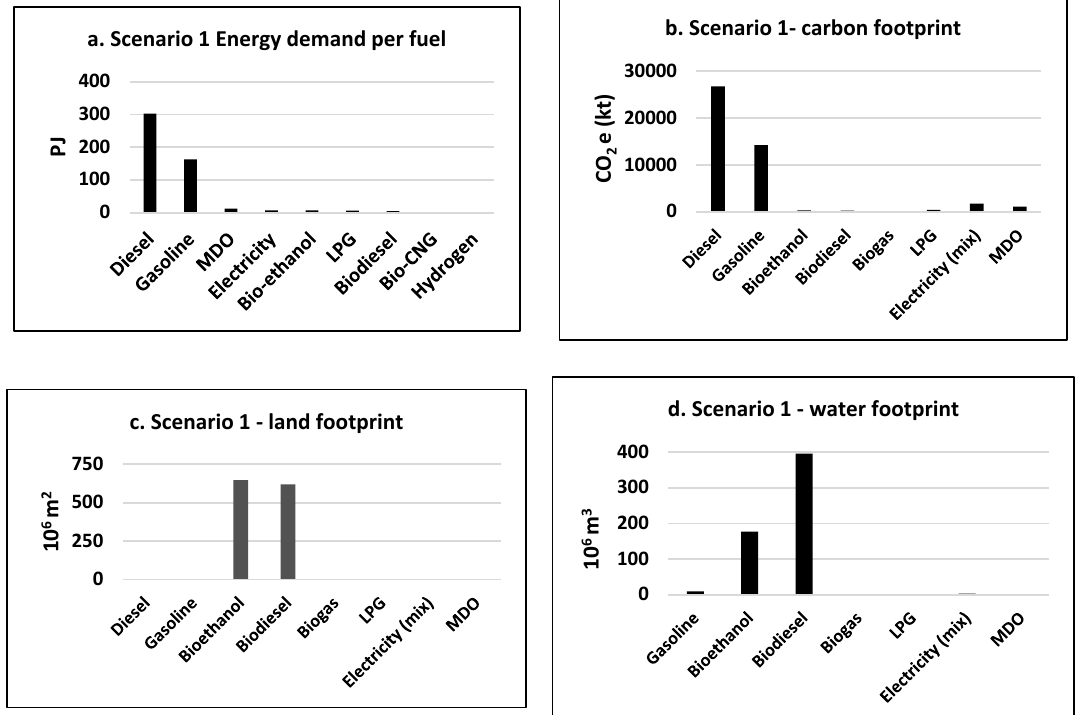
Figure 6. Here, ( a ) shows the total annual energy demand per fuel in scenario 1, the reference scenario (PJ); ( b ) shows the annual carbon footprint in scenario 1, the reference scenario (kt CO 2 e); ( c ) shows the annual land footprint in scenario 1, the reference scenario (m 2 ); ( d ) shows the total annual water footprint (green, blue and grey) in scenario 1, the reference scenario (m 3 ). Water 2020 , 12 , x FOR PEER REVIEW